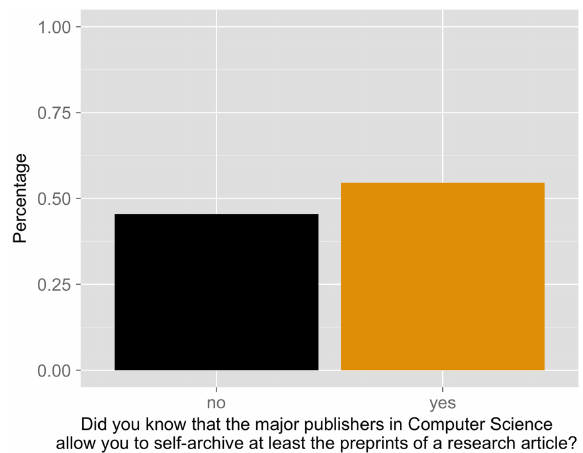
Figure 3. Answers to the question: Did you know that the major publishers in computer science allow you to self-archive at least the preprints of a research article?